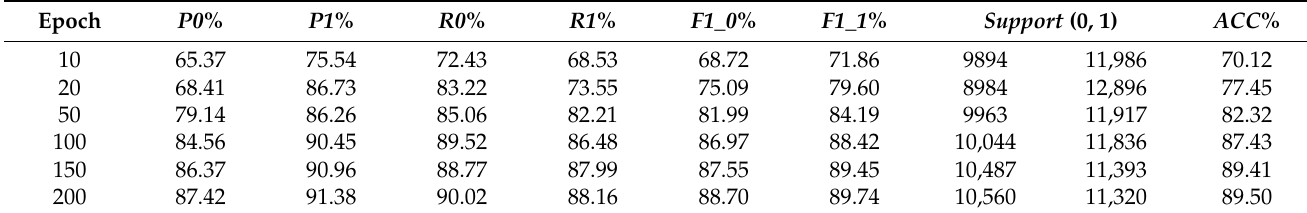
Table 2. Experimental results of AttNeSt.